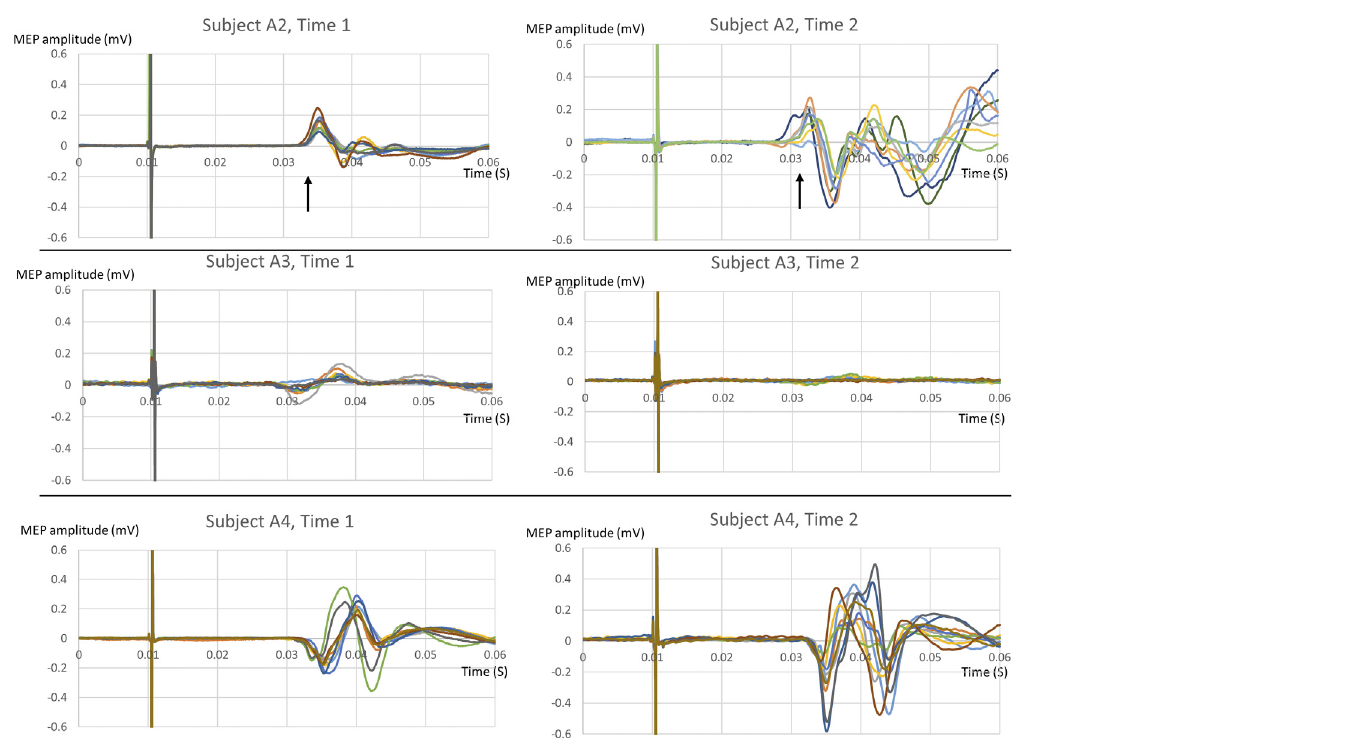
Fig 3. Variability in Motor Evoked Potentials in people with AHC. Each row shows two graphs of overlaid traces of 10 individual MEPs, performed using the same parameters, in the same subject, at different times during the same testing session. A change in MEP amplitude can be seen. In subject A2, there is also a change in MEP latency (average latency marked with an arrow).